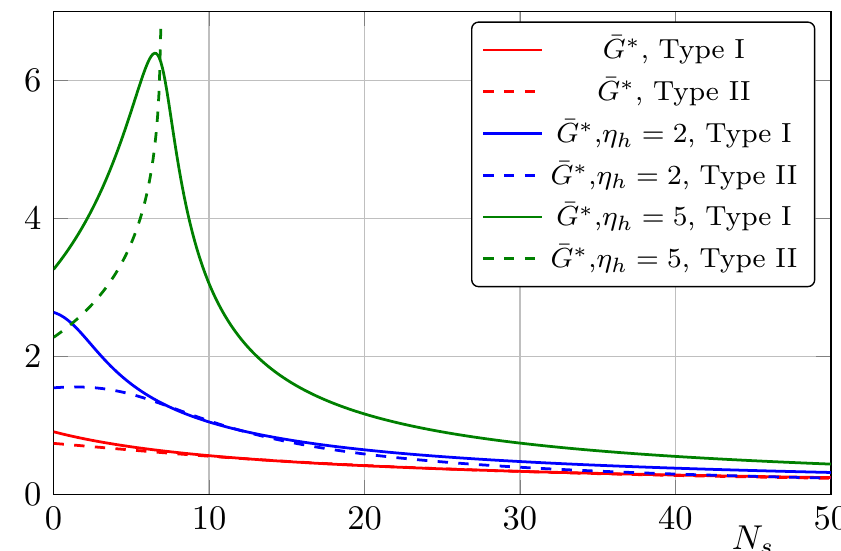
Figure 7: Fixed-point values of the background Newton coupling for a type-I (con- tinuous lines) and a type-II regulator (dashed lines) with the background-field ap- = − 2, red lines), and in hybrid cases with η proximation ( η h η = 5 (green lines). See App. A for the definitions of type-I and -II h